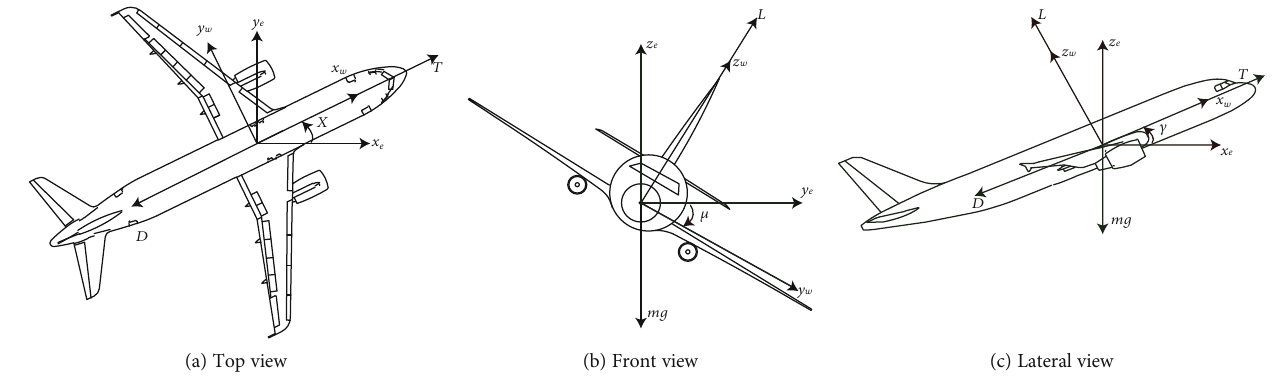
Figure 1: Aircraft state and